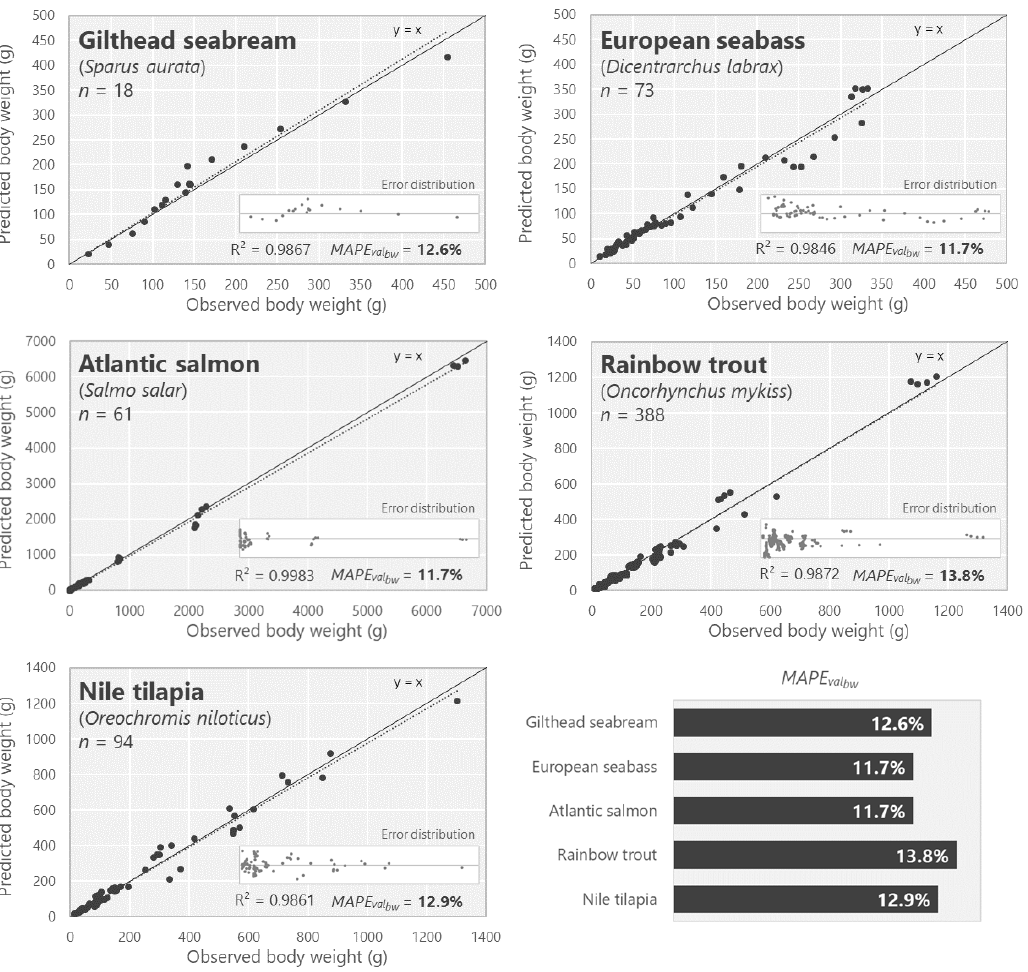
Figure 3. Scatter plots showing predicted versus observed body weight for the validation data set of each species, where n is the number of predicted-observed value pairs and 𝑀𝐴𝑃𝐸 𝑣𝑎𝑙𝑏𝑤 is the mean absolute percentage error. The solid line denotes the line of equality ( y = x ) and the dotted line is the linear trendline. Inside each plot, in a smaller frame, is shown the relative error ( y -axis) distributed over the body weight range ( x -axis). On the lower-right corner, a bar plot shows a comparison between the 𝑀𝐴𝑃𝐸 𝑣𝑎𝑙𝑏𝑤 values obtained for the different species.